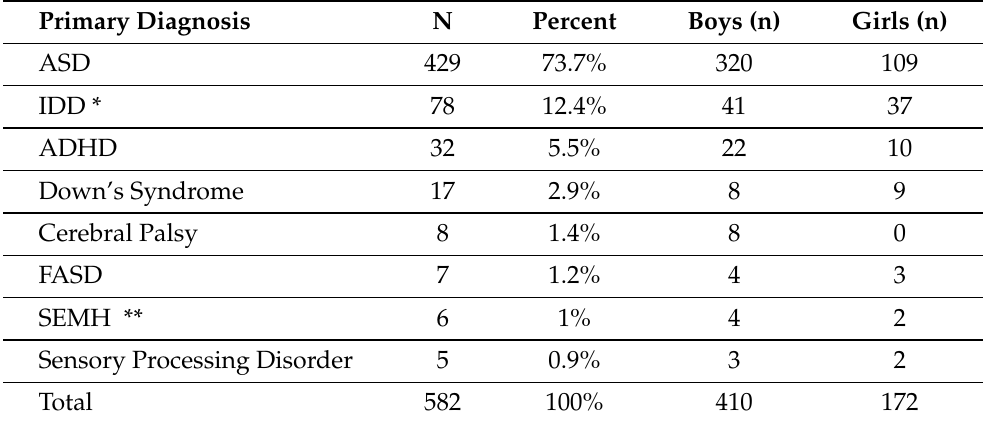
Table 1. Primary Diagnosis of Children.